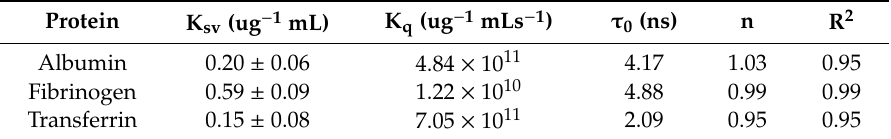
Table 1. The Stern–Volmer constant (KSV), biomolecular quenching rate constant (kq), lifetime ( τ 0 ), and the number of the binding site (n) for four classes of proteins interacted with the SiQD-De / F127 nanoparticles. R 2 shows a good fit with Equation